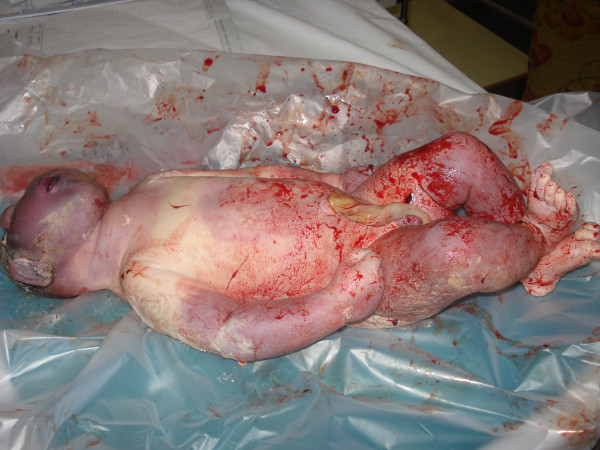
Baby with cyclopia.